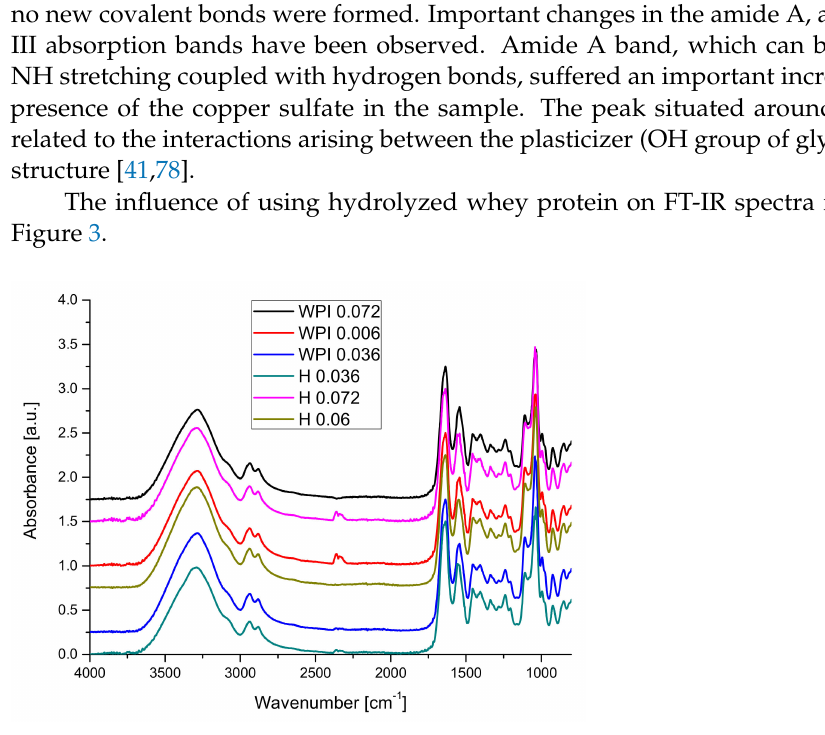
Figure 3. The influence of the WPH on of the FT-IR spectra of